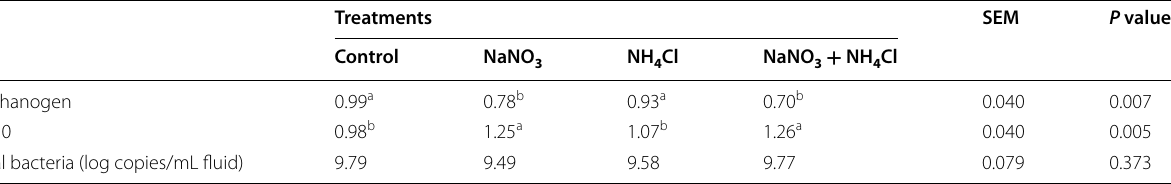
Values with different lowercase and capital superscripts in the same row differ significantly at P < 0.05 and P < 0.01, respectively Table 6 Effects of treatments on the number of total bacteria and the relative proportion of methanogen and NC10 in total